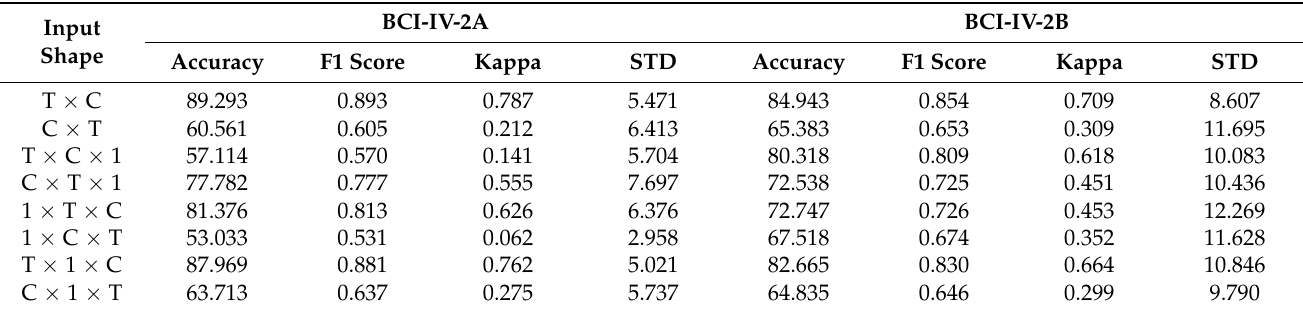
Table 5. Statistical Values of BCI-IV-2A and BCI-IV-2B